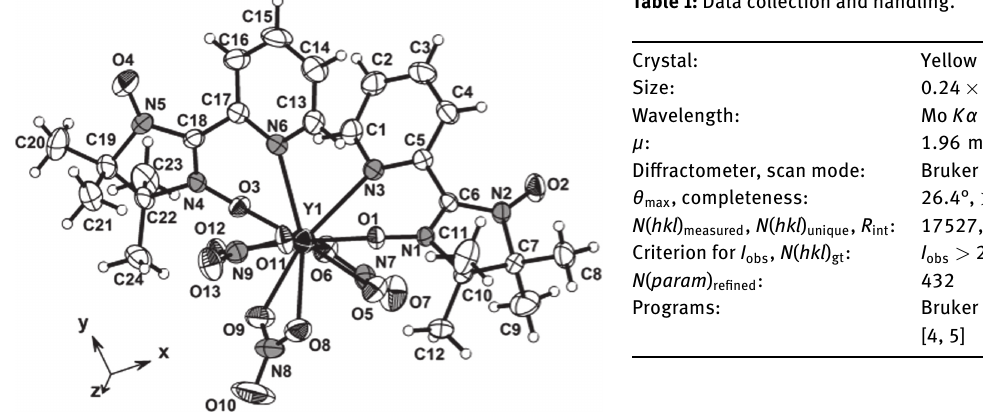
Table 1: Data collection and